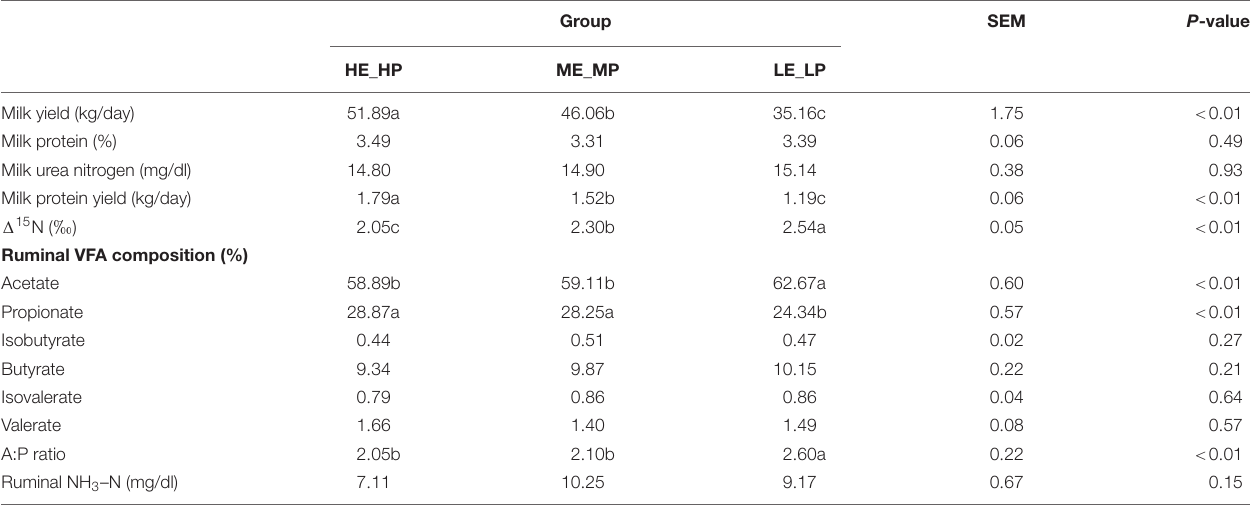
TABLE 1 | The production, nitrogen utilization efficiency indexes, and rumen fermentation parameters of dairy cows.